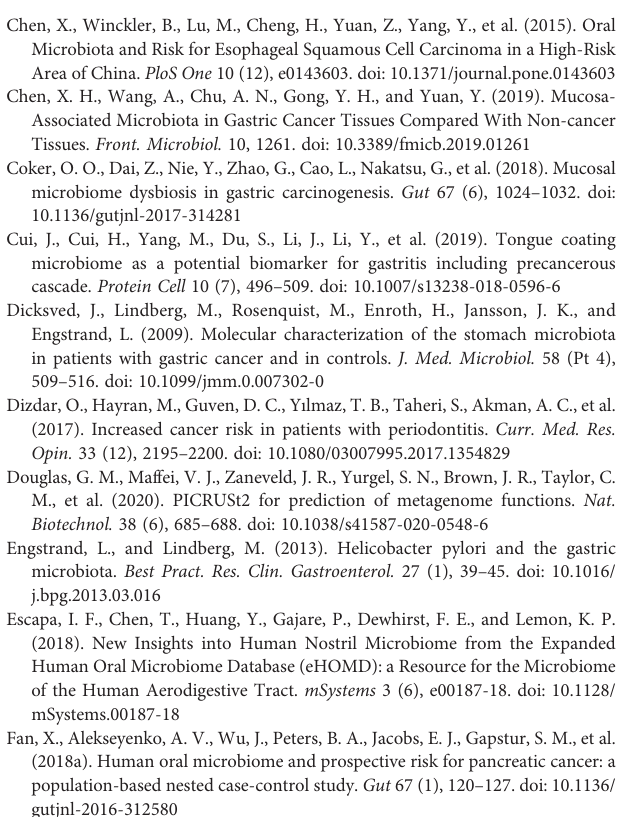
most abundant (A) phyla and (B) genera detected in the salivary microbiota in SG, AG, and GC patients. Supplementary Figure 4 | Microbiological features of the salivary microbiota associated with different histological stages of gastric tumorigenesis. (A) Bacteria taxa that enriched in each histological stage were determined by LEfSe with Kruskal – Wallis test P <0.05 and log 10 LDA score>3.4. (B) ROC curves analysis to evaluate the discriminatory potential of salivary bacteria in identifying GC out of pre- malignant lesions. (C) The top 10 bacterial genera that are most important for discriminating between SG, AG, and GC. Each genus is ranked according to an importance score (mean decrease accuracy). Supplementary Figure 5 | Network analyses reveal commensal relationships among the salivary bacteria. Spearman correlation network analyses showing the commensal relationships among the top 30 most abundant genera in the salivary microbiota of (A) super fi cial gastritis, (B) atrophic gastritis, and (C) gastric cancer. Taxa are represented as nodes, taxa abundance as node size, and are colored based on their belonging phylum. Edges represent signi fi cant correlations (Holm- corrected P < 0.05) among these taxa. Red and blue edges represent positive and negative correlations, respectively. Supplementary Figure 6 | Functional changes in the salivary microbiota are associated with the progression of gastric carcinoma. PICRUSt2 predicted metabolicpathwaysthatsigni fi cantlydifferentinthesalivarymicrobiotaofpatientsat different progressive histological stages of gastric tumorigenesis. Signi fi cance was determined by using Kruskal – Wallis rank sum test with BH-adjusted P < 0.05. Supplementary Code 1 | R code and taxa abundance table used for constructing the random forest model and generating the AUC ROC